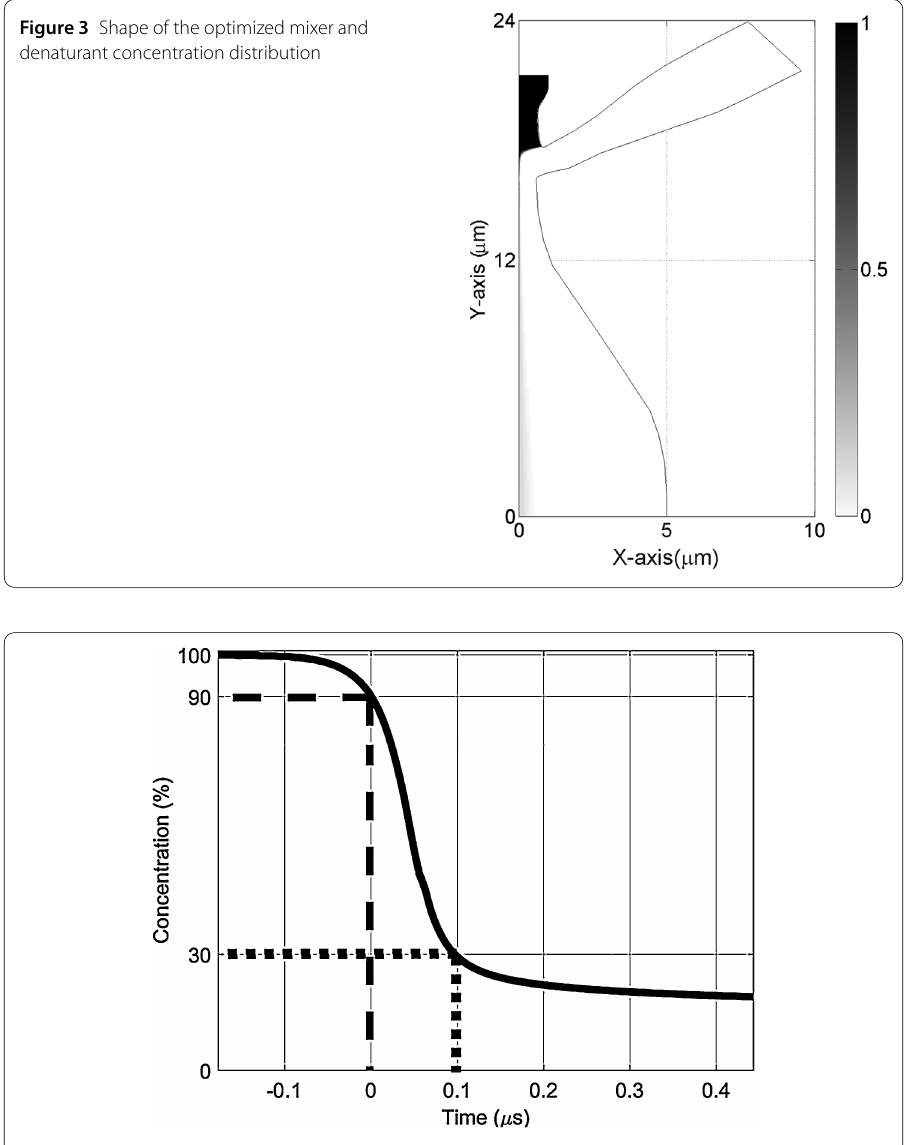
Figure 4 Transient behavior of the denaturant concentration of a particle in the mixer symmetry